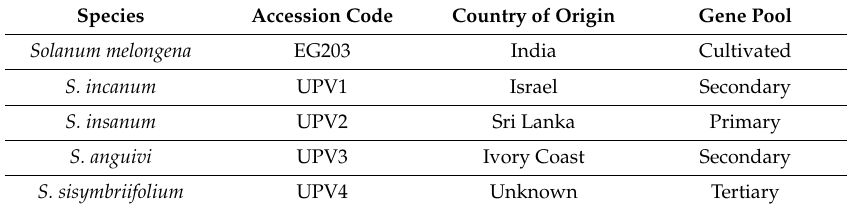
Table 5. Cultivated eggplant and wild relatives were used for interspecific hybridization experiments.